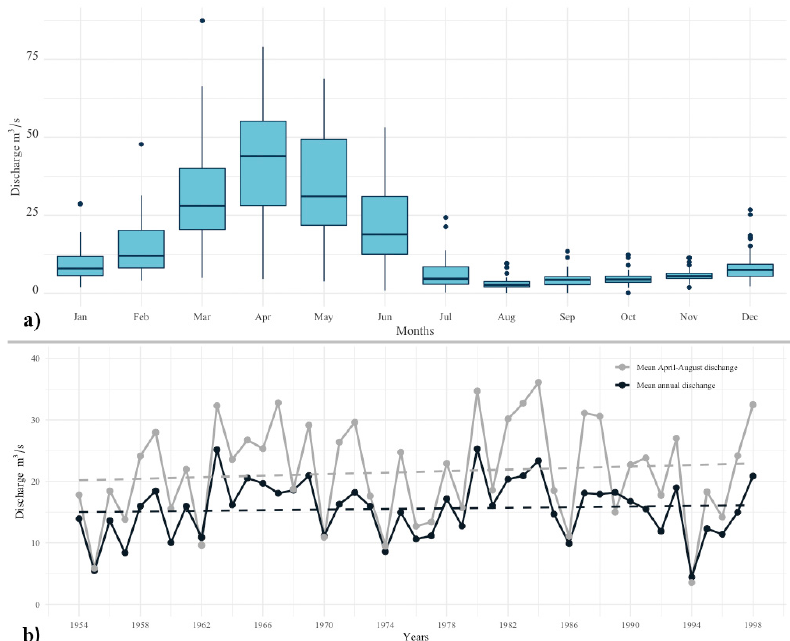
Figure 3. ( a ) The monthly hydrograph for Gökırmak River (at Kuylu¸s) gauge for the period of 1954– 1998. The boxes of the boxplot representing half of the central data which start with the first quartile and end with the third quartile. Horizontal black line in the box represents the median. ( b ) The mean annual (black) and mean April–August (gray) discharge (m³/s) with trend lines (dashed). The trend function is y = − 102 + 0.0624 x for mean annual discharge and y = − 33.4 + 0.0248 x for mean April– August discharge, where y indicates discharge and x indicates year.